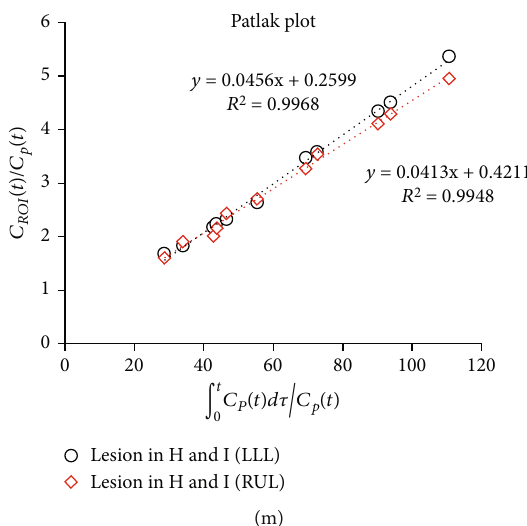
Figure 4: Representative sMPLC and IPM examples. (a – f) sMPLC examples. (a – c) FDG-PET of a patient (patient #1 in Table 3) with two synchronous primary lung tumors. Dynamic FDG PET/CT revealed an acinar adenocarcinoma in the right upper lobe (b) (white